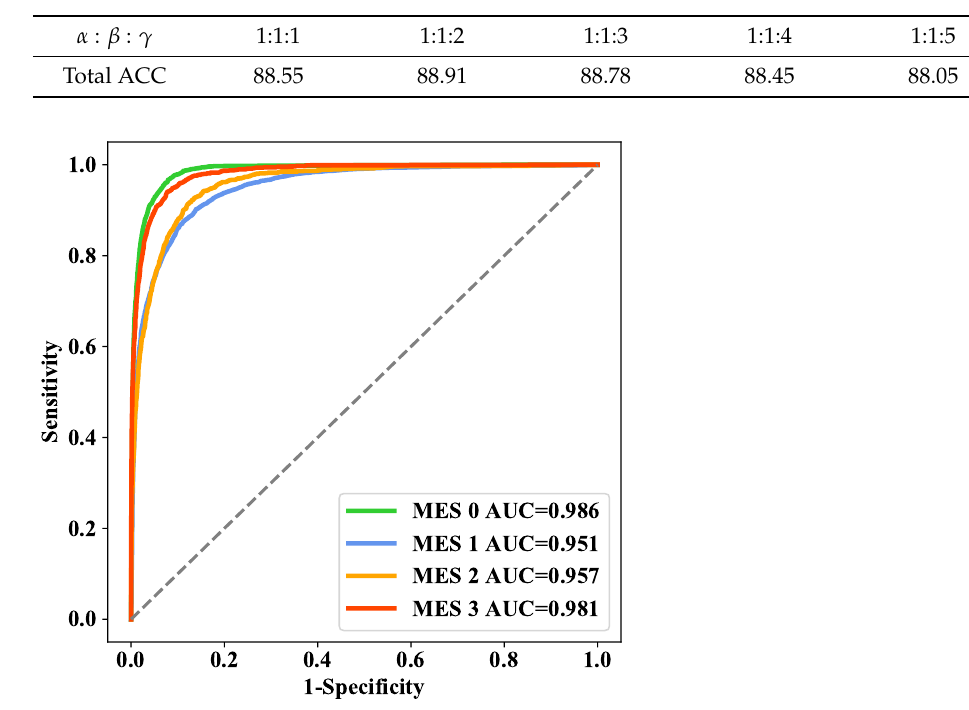
Figure 6. Performance comparison of PHF 3 under different Newton–Schulz iterations L . Table 3. Exploration of the ratio of α , β , and γ .